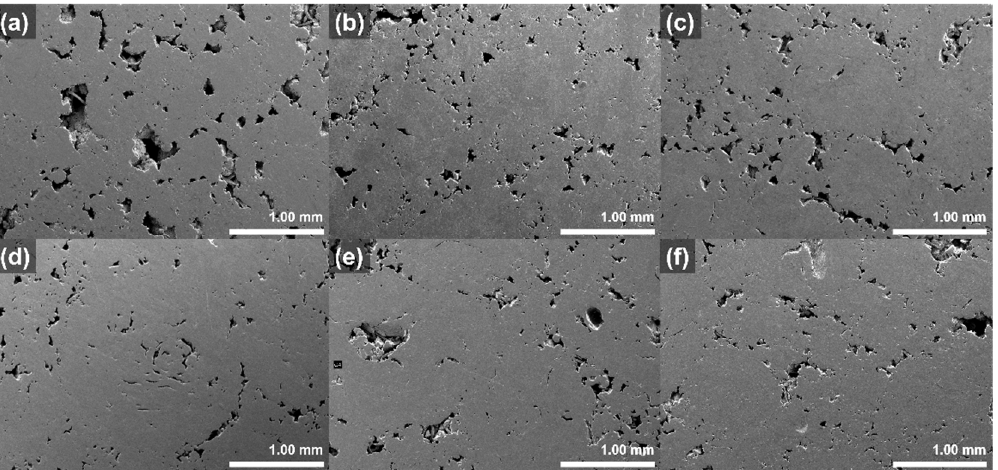
Figure 5. SEM images of graphite blocks before and after impregnation at various pressures: ( a ) pristine, ( b ) 10 bar, ( c ) 20 bar, ( d ) 30 bar, ( e ) 40 bar, and ( f ) 50 bar.